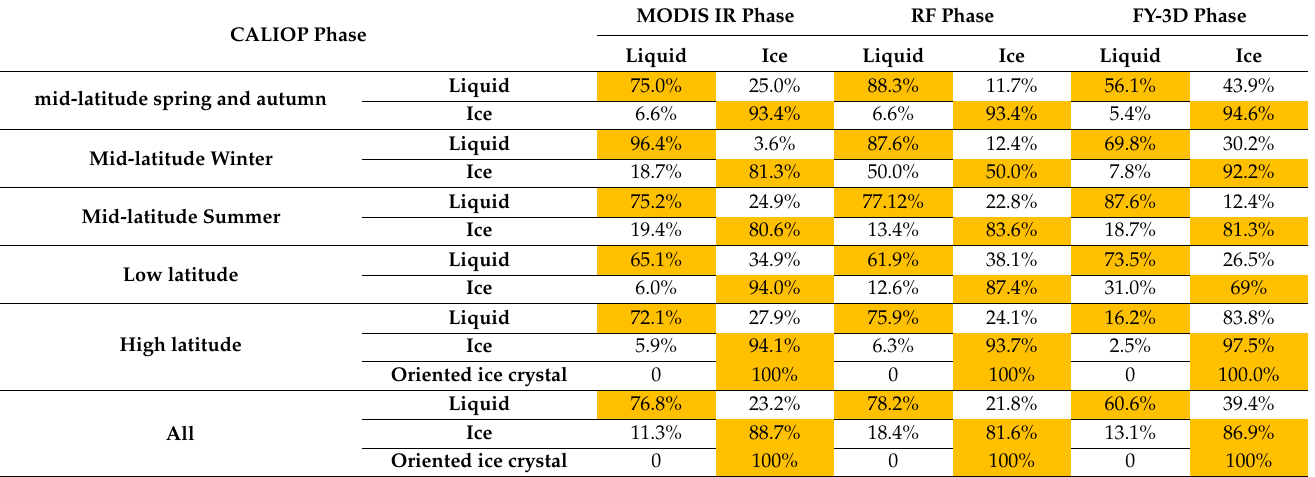
Table 6. CALIOP cloud-top phase cross-validation with MODIS IR, RF, and operational FY-3D/MERSI-II CP products based on season and latitude (the uncertain phase in MODIS and RF products was eliminated, and the mixed and ice phases were merged in the operational FY-3D/MERSI-II